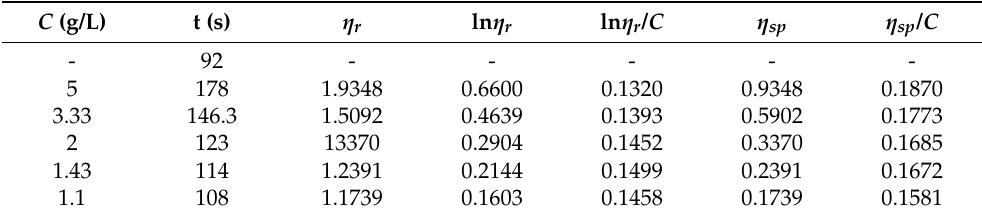
Table 3. Experimental data of